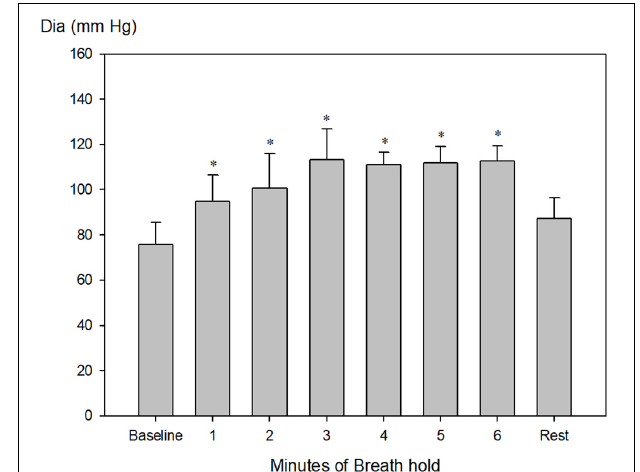
FIGURE 5 | Invasively measured diastolic blood pressure (Dia) during pool apnea. Diastolic blood pressure increased every minute from 76 ± 3 to a maximum of 113 ± 5 mm Hg after 3 min of apnea compared to rest and remained constant hereafter until termination of breath hold ( ∗ P < 0.001 compared to baseline, n =